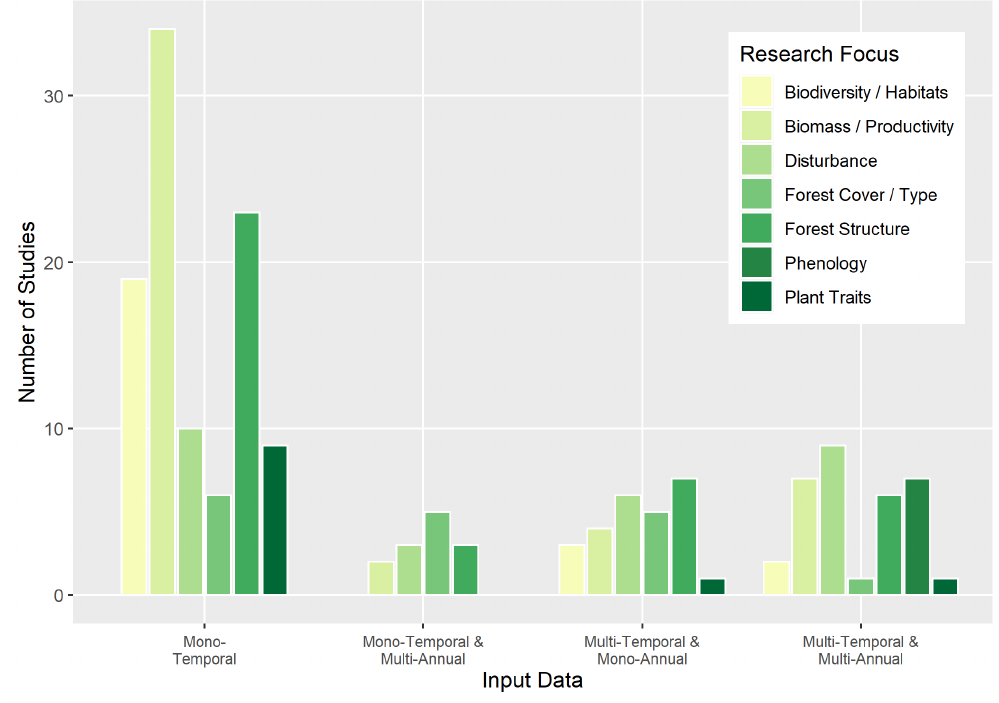
Figure 14. Temporal resolution of input data-sources and output products for seven application Figure14. domains.